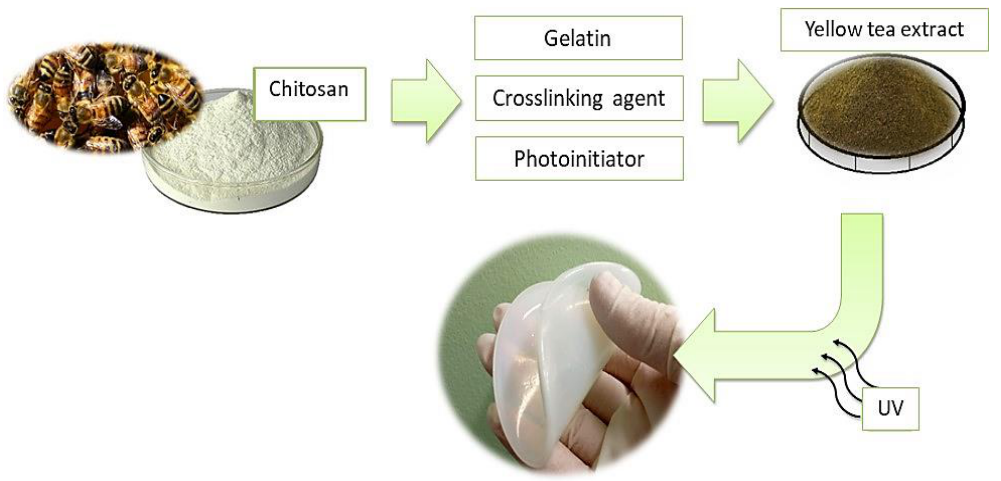
Table 1. Compositions of synthesized hydrogels.